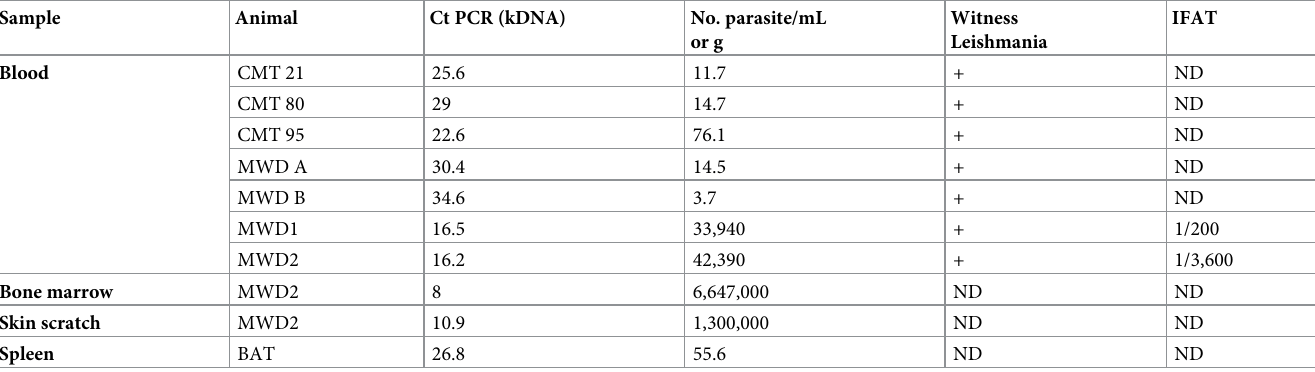
Table 3. Parasite load and serological test results for qPCR-positive